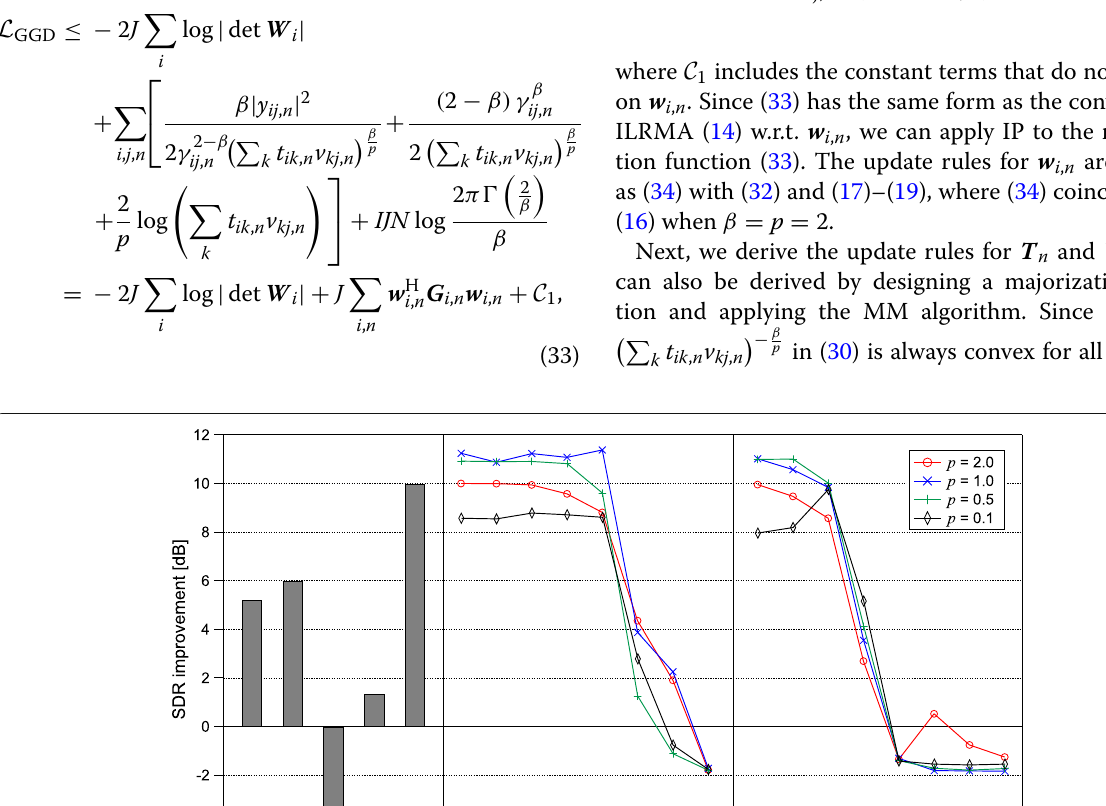
paper. By applying (31) to (30), the majorization function of (30) can be designed as